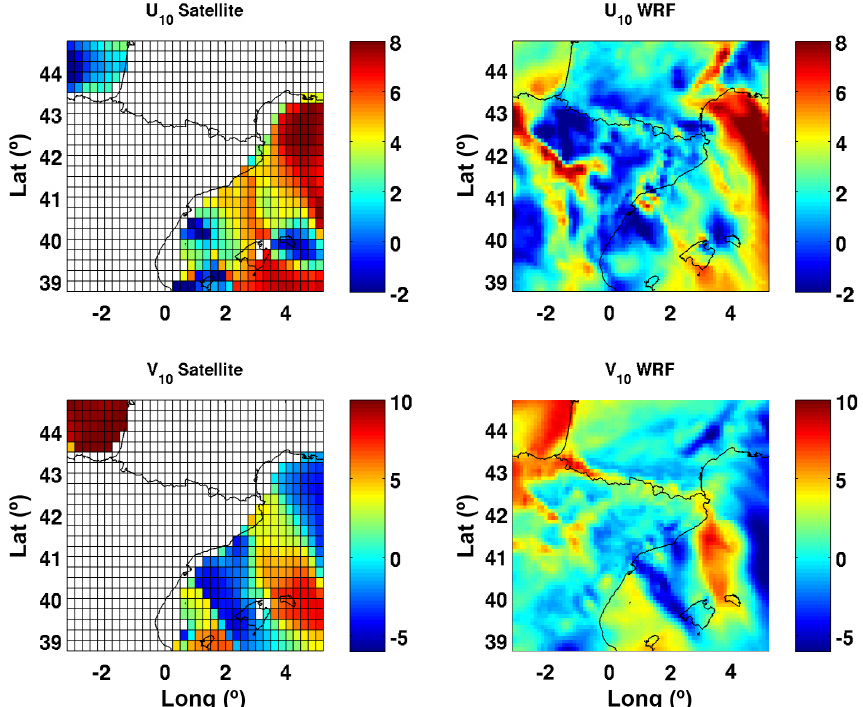
Figure 5. Wind components (top panels: east–west top; bottom panels: north–south) from the satellite gridded product for the study area (top panels) and from the results of the meteorological model (mesh M1). The figure corresponds to 1 January 2012 at 12:00UTC.